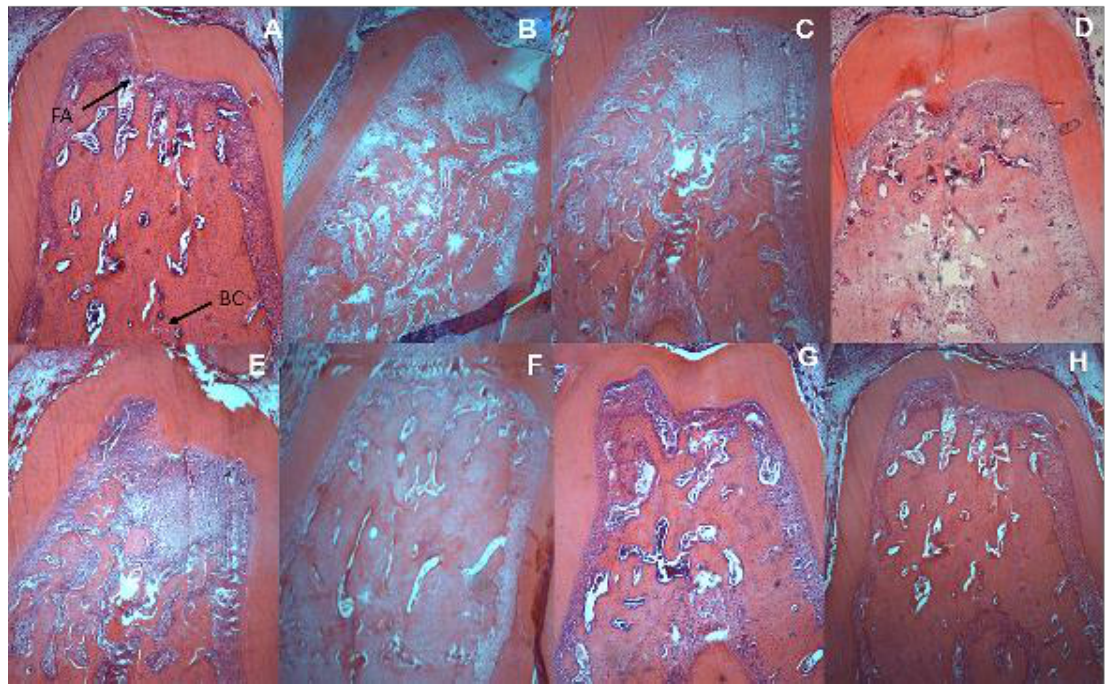
Figure 4. Histometric analysis showing the alveolar bone loss of animals with diabetes and/or periodontal disease treated or not treated with β-glucan at a dose of 30 mg/kg/day for 28 days: ( A ) control—FA, furcation area and BC, bone crest; ( B ) diabetes; ( C ) periodontal disease; ( D ) β-glucan; ( E ) diabetes + periodontal disease; ( F ) diabetes + β-glucan; ( G ) periodontal disease + β-glucan; ( H ) diabetes + periodontal disease + β-glucan; (Hematoxylin and Eosin; magnification 40×). Table 5. Histometric analysis of the duodenal fraction (mean ± standard deviation) of animals with diabetes and/or periodontal disease treated or not treated with β-glucan at a dose of 30 mg/kg/day for 28 days.